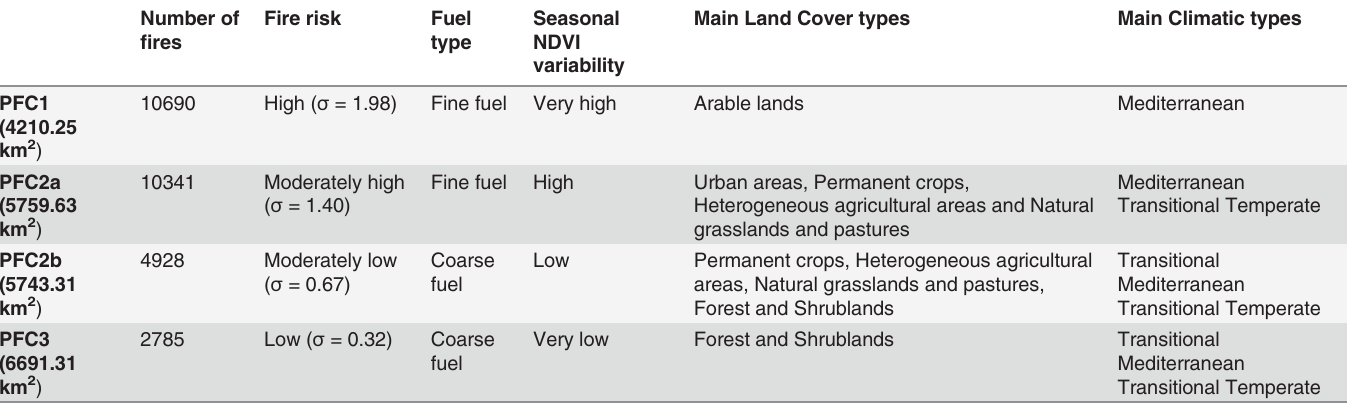
Table 4. Summary of the environmental characteristics of the phenological fuel classes (PFCs) obtained from the analysis. Number of fi